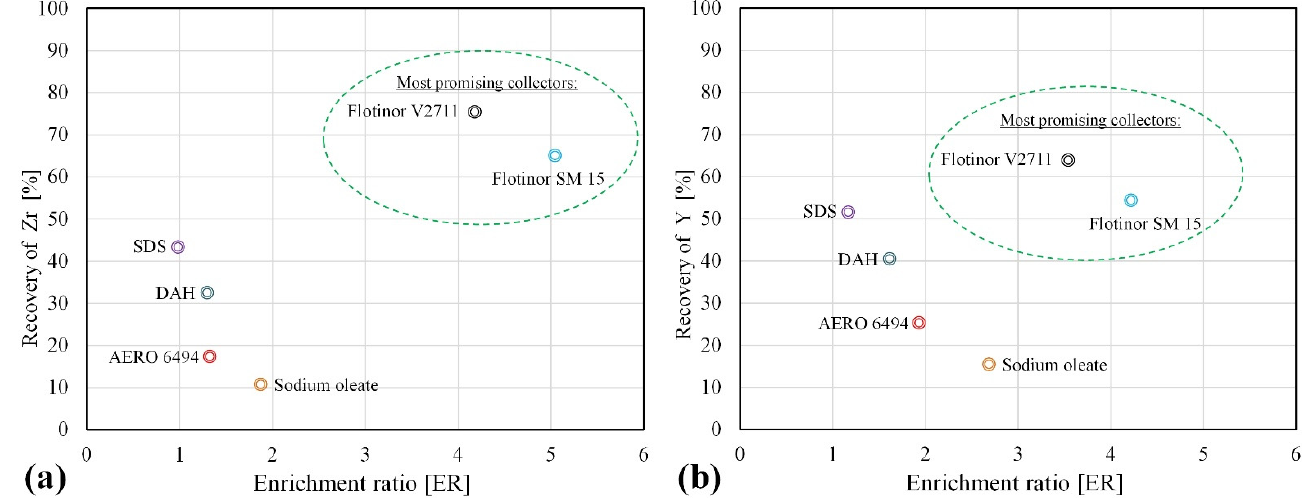
Figure 4. Selection of collectors for the selective flotation of zirconosilicates at the pH of 4: Zr ( a ) and Y ( b ).